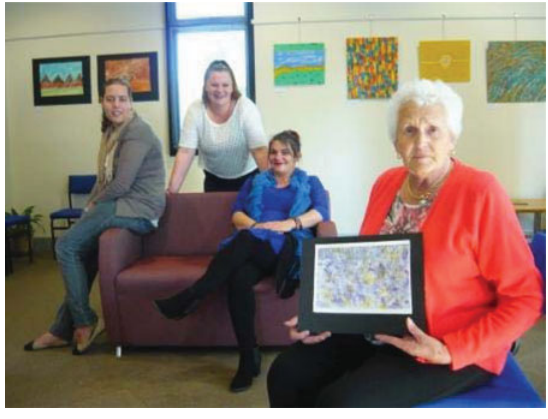
FIGURE 1 (Colour online) Murina students showing their art work.